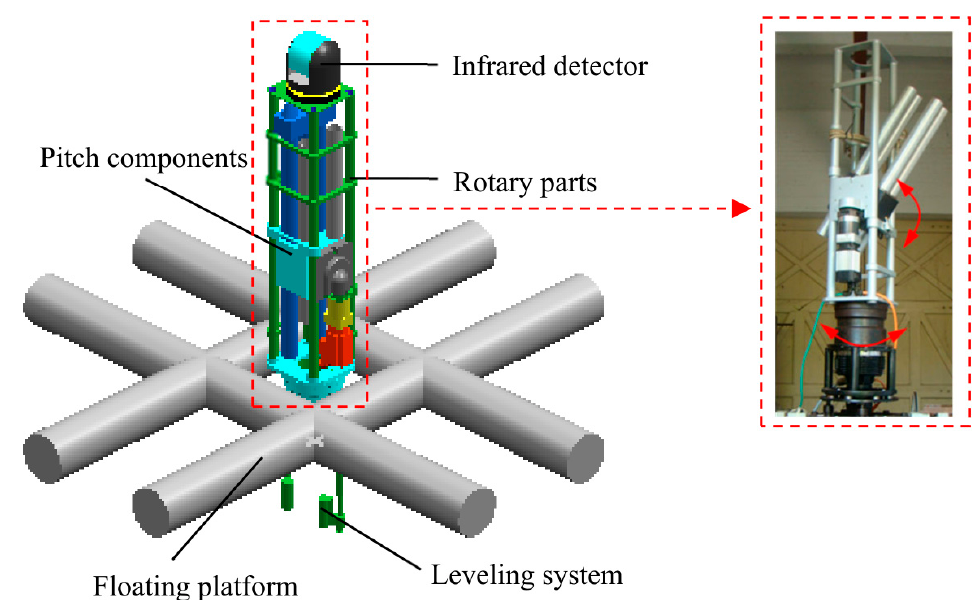
Figure 1. Structure diagram of the surface unmanned drifting platform.